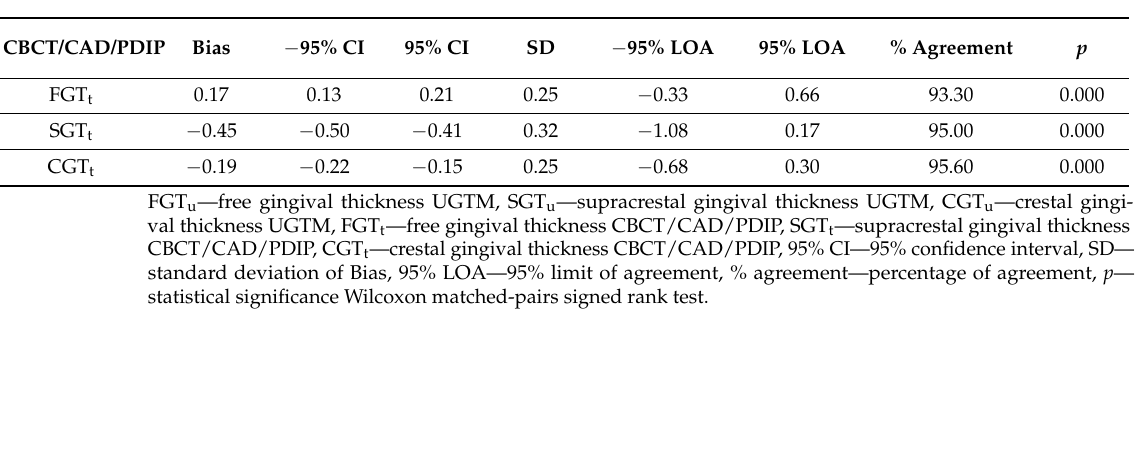
Table 5. Agreement between methods in the measurement of gingival